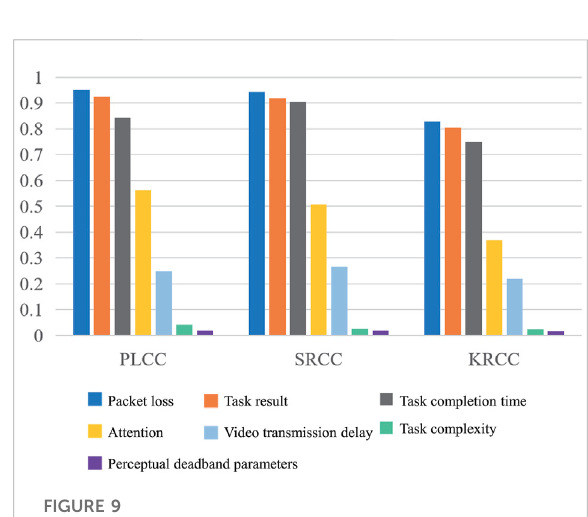
Correlation between each in fl uencing factor and